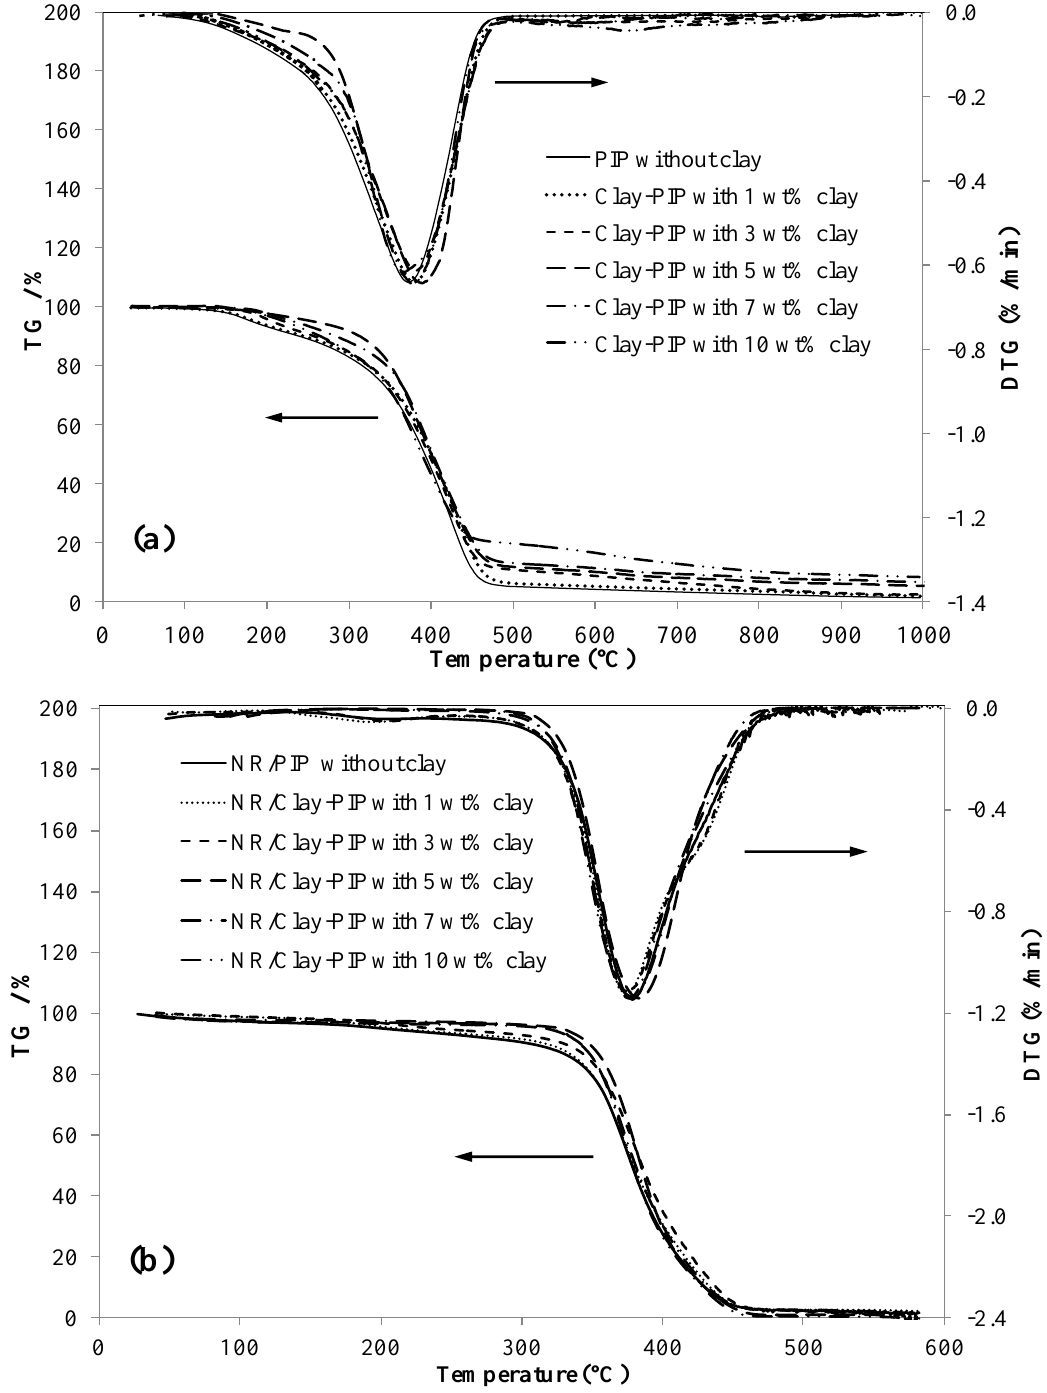
Figure 8. Thermogravimetric analysis (TGA) and DTG thermograms of the ( a ) Clay-PIP and ( b ) NR / Clay-PIP composites containing various nanoclay contents. The Clay-PIP latexes were prepared using SFE technique. The clay contents are relative to the monomer amount.